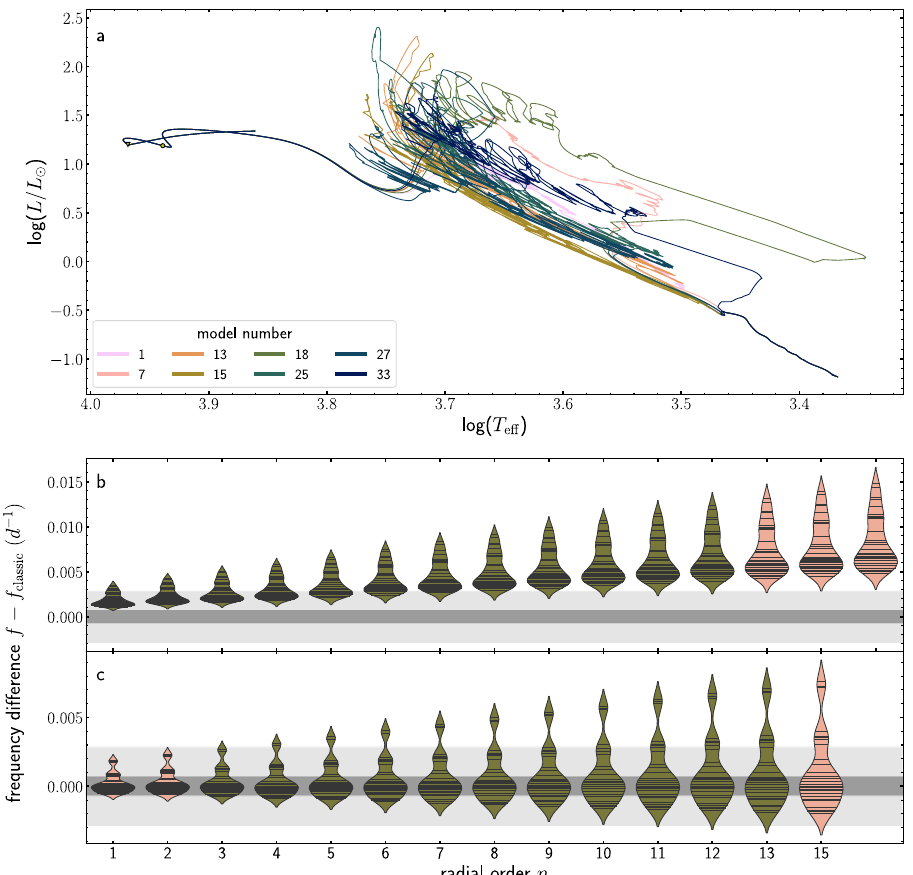
Fig.5|Comparisonbetweenthedifferentdisk-mediatedaccretionhistoriesfor thestandardinputphysics.a EvolutioninaHertzsprung-Russelldiagramofeight chosen models. These models have been selected to show the extent in the Hertzsprung-Russell diagram reached by different accretion histories while mini- mising the overlap between lines. See Supplementary Fig. 37 for a version with all models. b The distribution of frequency values in the 34 models for the pre-main sequence phase. The frequency differences are presented as violin plots grouped according to the radial order.In thistype ofplot, eachhorizontal line corresponds